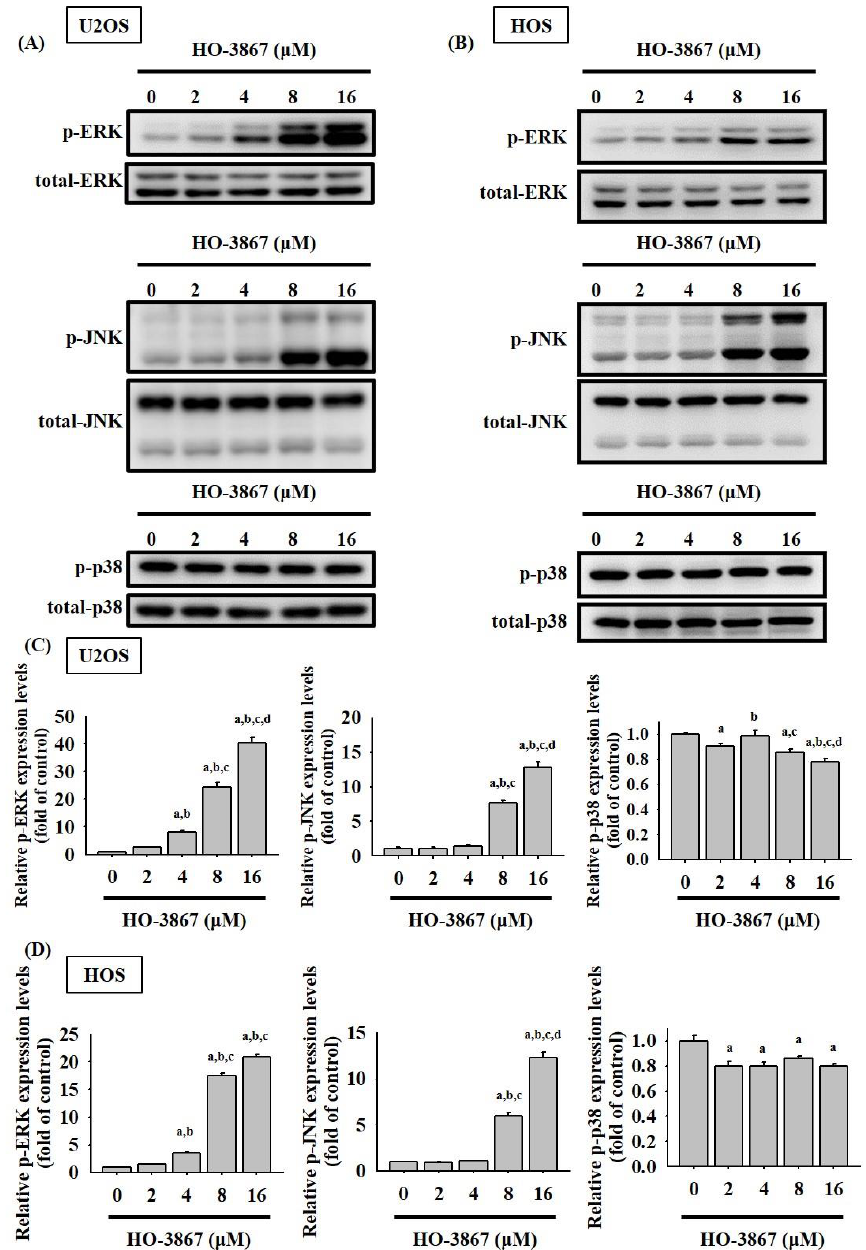
Figure 6. Analysis of phosphorylation of ERK1/2, JNK1/2, and p38 in HO-3867-treated cells. ( A , B ) After experimental concentration range of HO-3867 treatment for 24 h, Western blot anal- ysis was performed to measure expressions of MAPKs, as well as their phosphorylation in ( A ) U2OS and ( B ) HOS cells. ( C , D ) Next, quantitative analysis was assessed. n = 3. p -ERK: U2OS: F = 661.501, p < 0.001; HOS: F = 4585.730, p < 0.001; p -JNK: U2OS: F = 494.446, p < 0.001; HOS: F = 855.033, p < 0.001; p -p38: U2OS: F = 33.591, p < 0.001; HOS: F = 23.845, p < 0.001. a Significantly different, p < 0.05, when compared to control. b Significantly different, p < 0.05, when compared to 2 µ M. c Significantly different, p < 0.05, when compared to 4 µ M. d Significantly different, p < 0.05, when compared to 8 µ